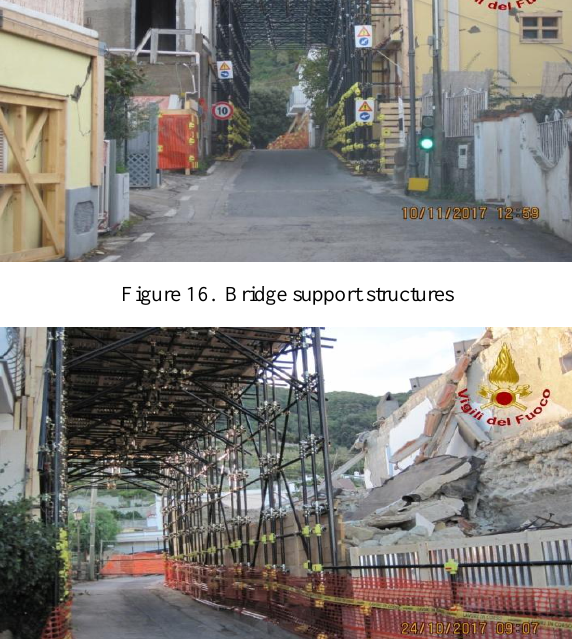
Figure 19. Examples of wooden planking for